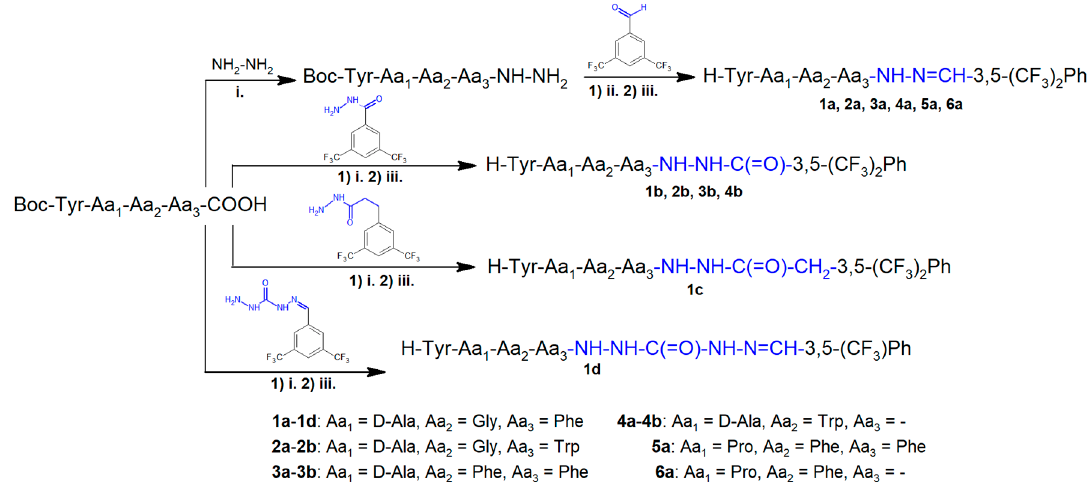
Figure 3. Correlation of RP-HPLC retention times of the studied compounds with theoretical LogP values. Compounds 1c and 1d excluded from the correlation. Points are colored so that analogues with the same peptide sequence have the same